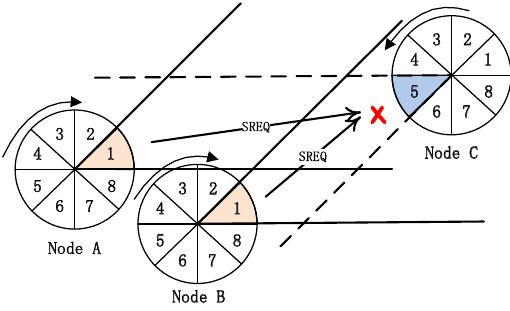
Figure 4. The first “link collision” problem-the collision of the first